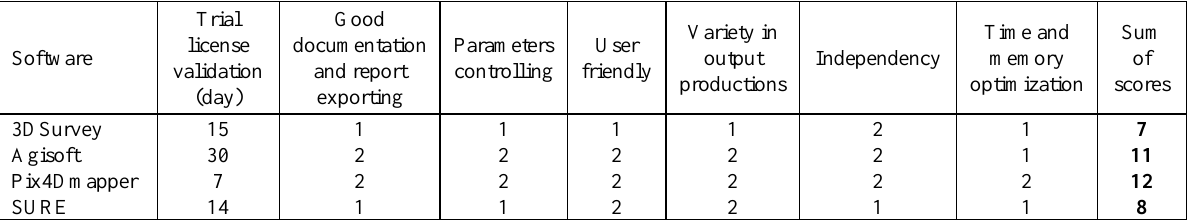
Table 3. Characteristics of software